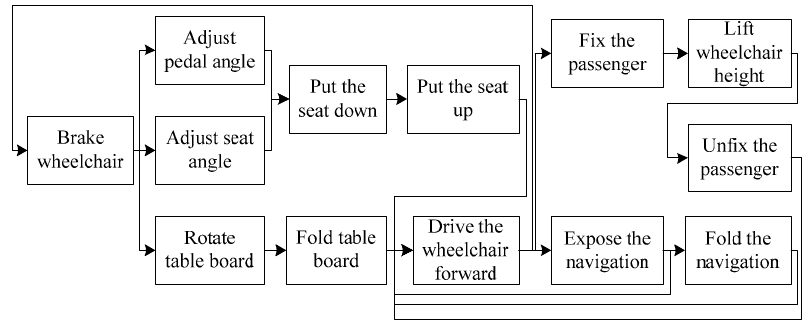
Figure 12. Function chain of the first concept.